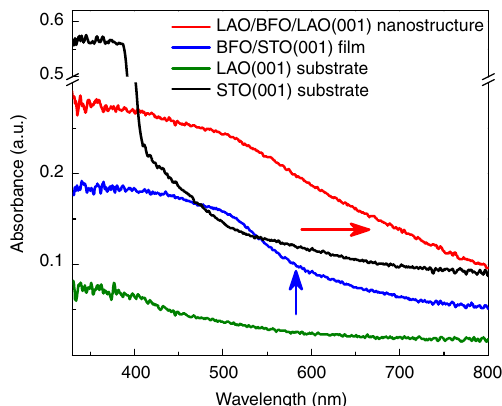
Figure 6 | Ultraviolet–visible absorption measurements on the LaAlO 3 /BiFeO 3 /LaAlO 3 (001) nanostructures. A uniform BiFeO 3 /SrTiO 3 (001) film with B 30nm thickness, a bare LaAlO 3 (001) substrate and a bare SrTiO 3 (001) (STO(001)) substrate are also measured here for